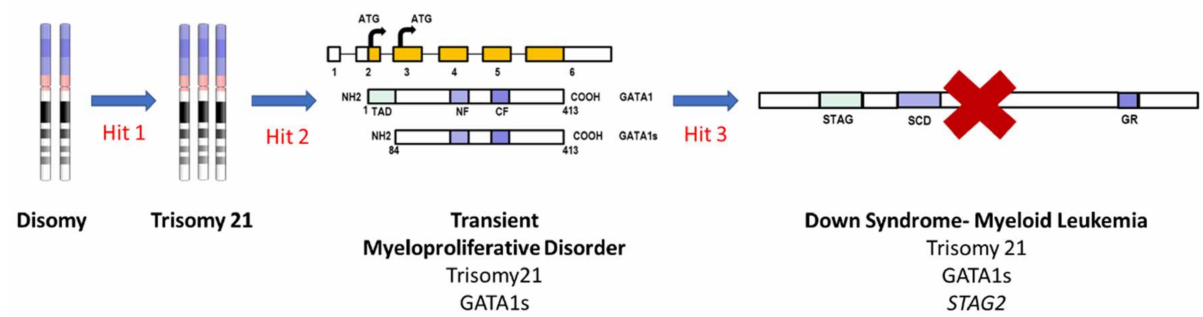
Figure 2. Schematic of stepwise evolution of DS-ML. The first step is trisomy 21 which augments the early hematopoiesis. In the next step, the mutation in GATA1 results in a truncated protein GATA1s causing TMD. Acquisition of addition mutations in cohesin complex component STAG2 resulting in loss of protein, leads to progression of TMD to DS-ML. Other cooperating mutations in genes belonging to epigenetic modifiers and signaling molecules can also lead to progression of TMD to DS-ML. TAD: trans-activation domain, NF: N-terminal zinc finger domain, CF: C-terminal zinc finger domain, STAG2: stromal antigen 2, SCD: stromalin conservative domain, GR: glutamine